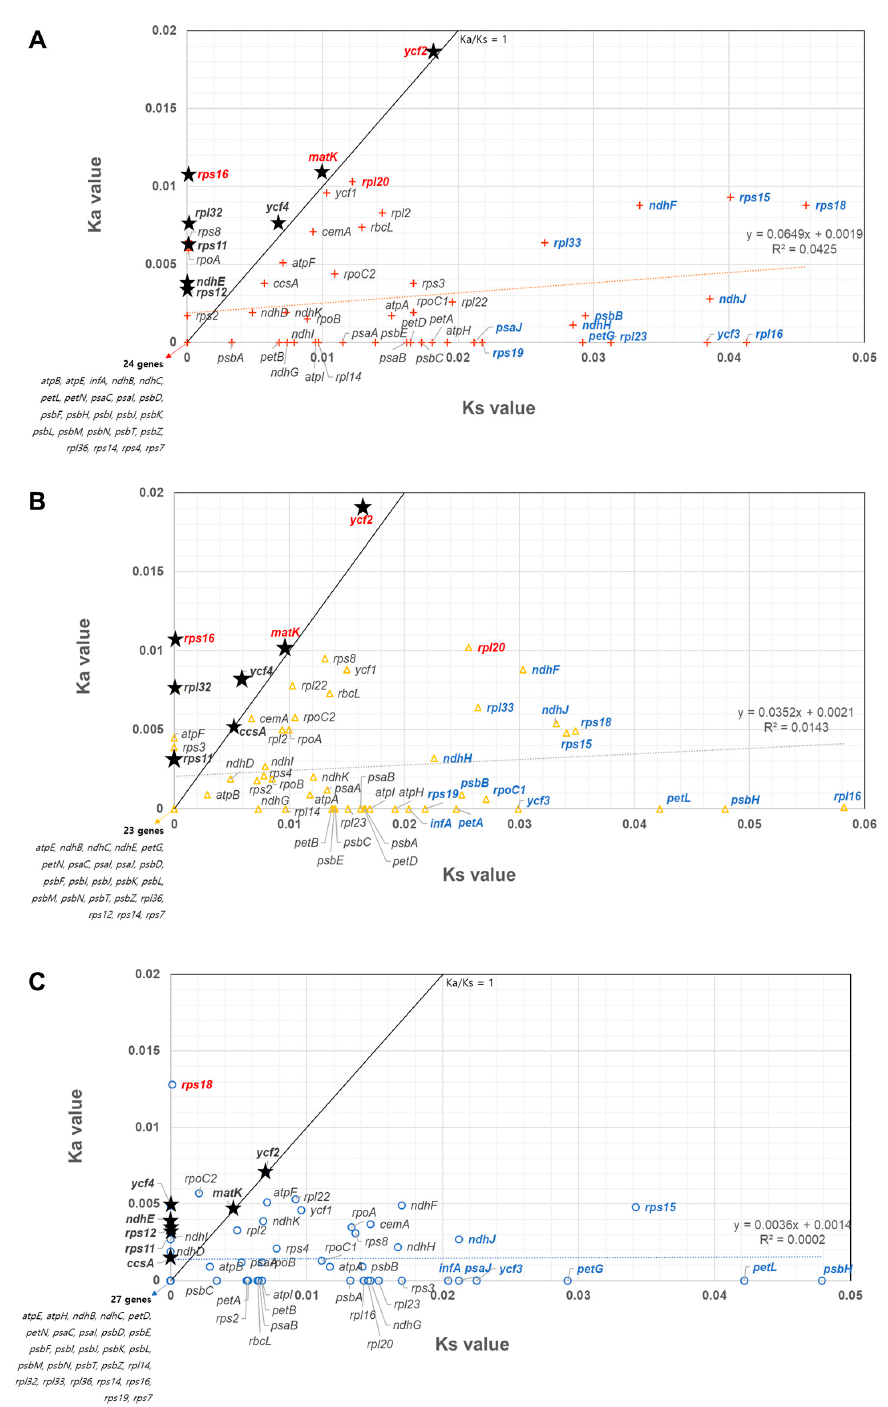
Figure 4. Chloroplast (cp) gene selection pressure of three Apiaceae species. Scatterplot of non-synonymous substitution (Ka) and synonymous substitution (Ks) values between Ledebouriella seseloides and Glehnia littoralis ( A ); between Peucedanum japonicum and G. littoralis ( B ); and between L. seseloides and P. japonicum ( C ). Ka and Ks values were calculated using CodeML and 76 protein-coding genes. Ka and Ks values are represented on the y-axis and x-axis, respectively. R 2 indicates a trend line. Red letters indicate genes with a Ka value greater than 0.01, and blue letters indicate genes with a Ks value greater than 0.02. Genes marked by an asterisk (*) are commonly positively selected genes in at least two analysis results. Ls, L. seseloides ; Pj, P. japonicum ; and Gl, G. littoralis .